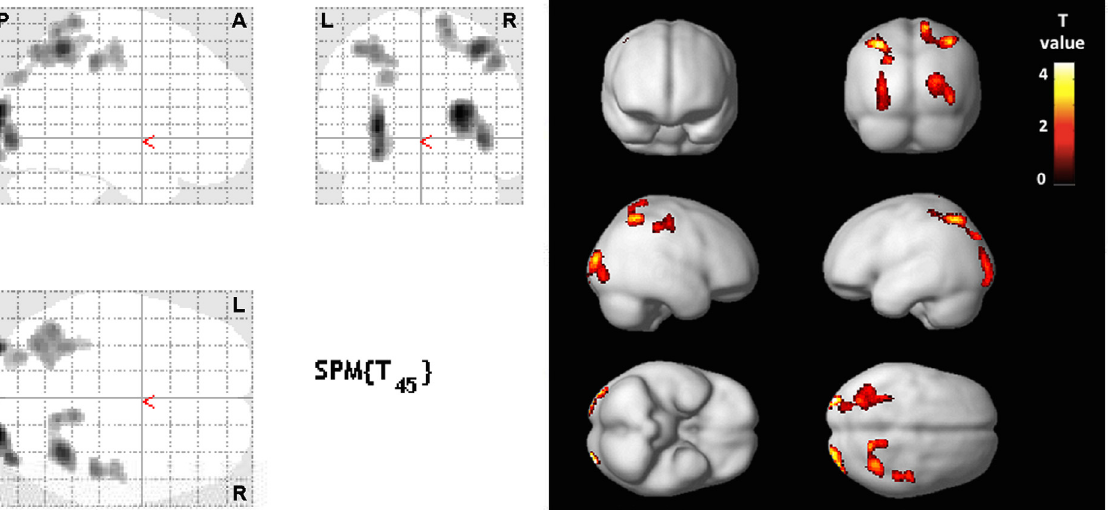
Fig 2. SPM map. Positive correlation between brain perfusion and Stroop color and word Z-scores with adjustment for age, sex, socio-cultural level and time delay between brain SPECT and neuropsychological testing. Linear regression analysis shows impairment of posterior associative areas. Significant clusters are displayed with T-score values on 2-dimensional axial, coronal and sagittal orientations (glass-brain — left panel) and projected onto a brain rendered 3D MIP (right panel). P-value < 0.005 at the voxel level for clusters (cid:1) 100 contiguous voxels (corrected for cluster volume). L, left; R, right; A, anterior; P,